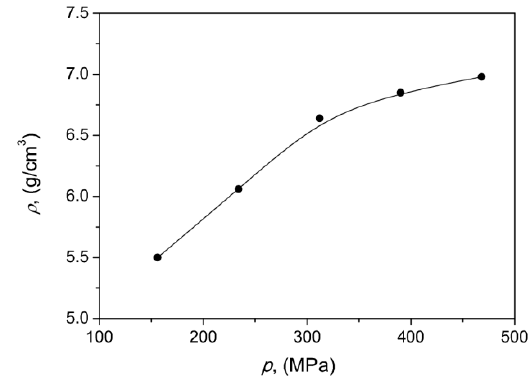
Figure 4. Experimental dependence of material density versus compaction pressure.